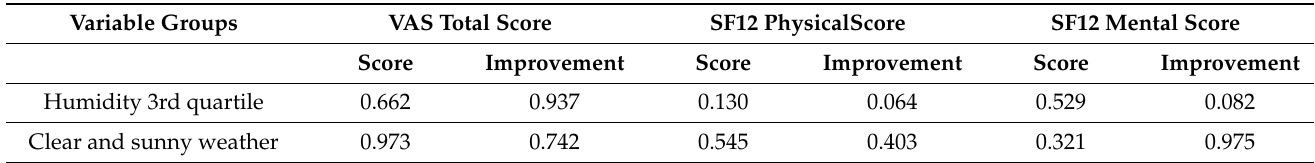
Table 3. The p -values observed in the hypothesis testing for 6-month